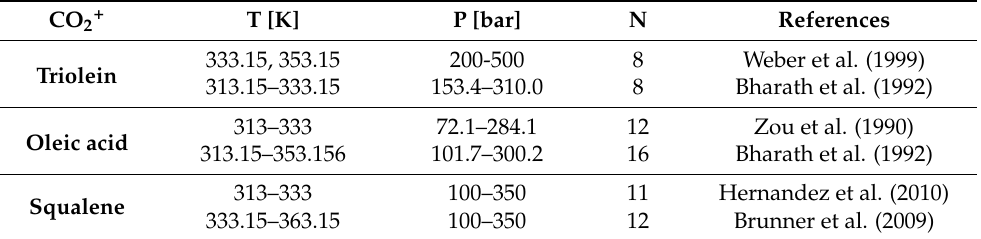
Table 4. Experimental gaseous-liquid equilibrium data for the binary systems oleic acid-CO 2 , squalene-CO 2 , and triolein-CO 2 used to compute the binary interaction parameters of RK-Aspen EOS